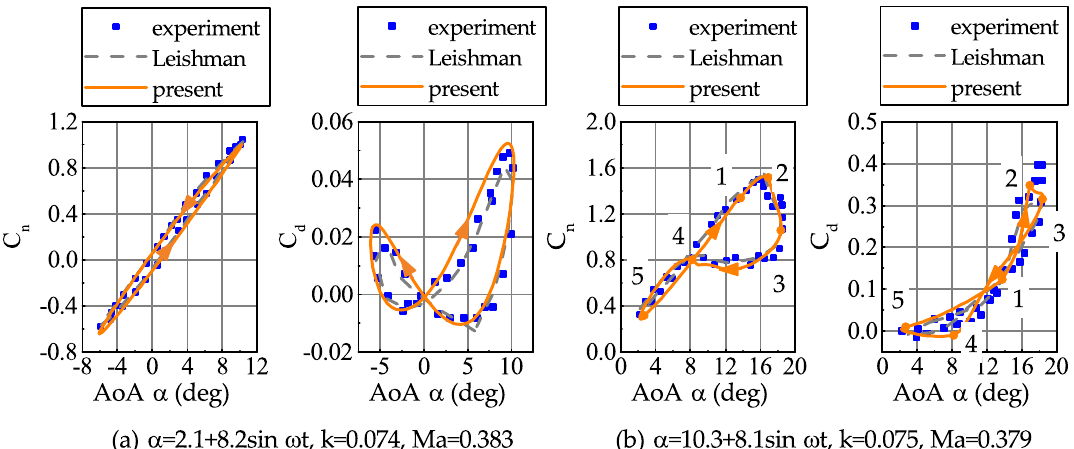
Figure 2. NACA0012 dynamic stall validation: (1) the leading edge vortex forms; (2) the vortex convects to the trailing edge; (3) the vortex decays in the wake; (4) the reattached flow starts; (5) the attached flow starts.